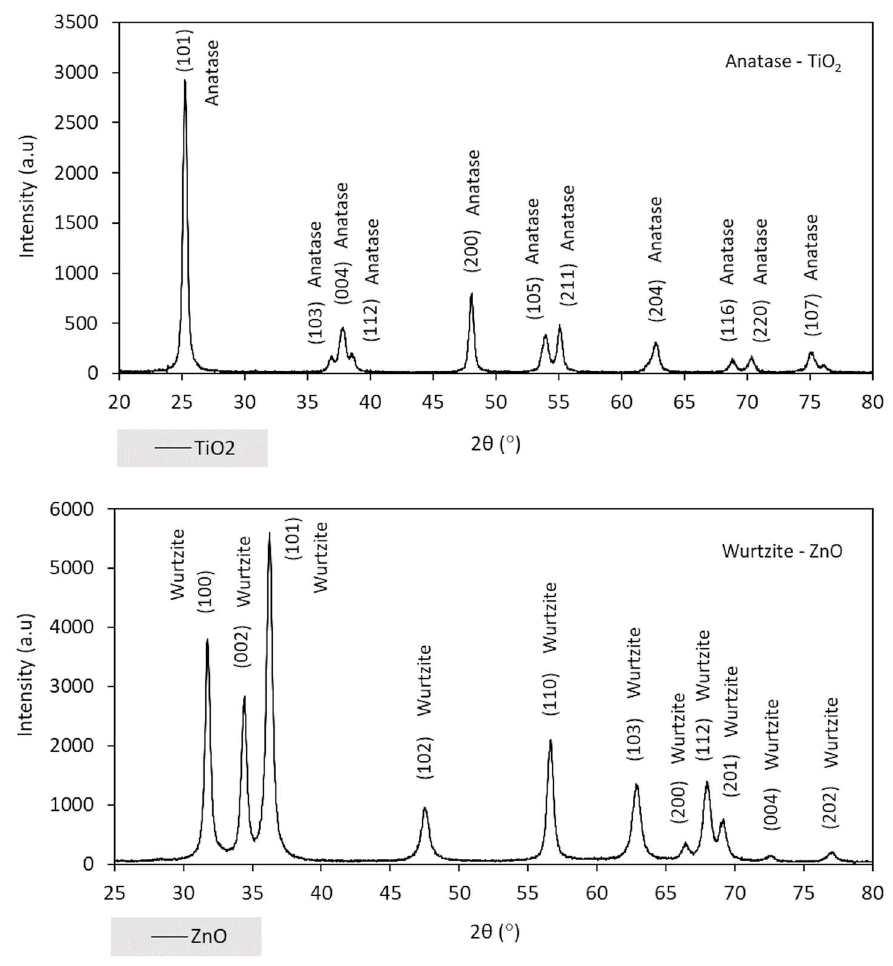
Figure 1. Nano-TiO 2 ( a ) and nano-ZnO ( b ) micrographs obtained by transmission electron micros- copy technique.